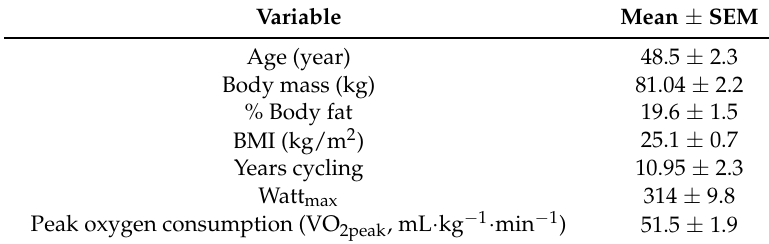
Table 1. Subject characteristics ( n = 20).